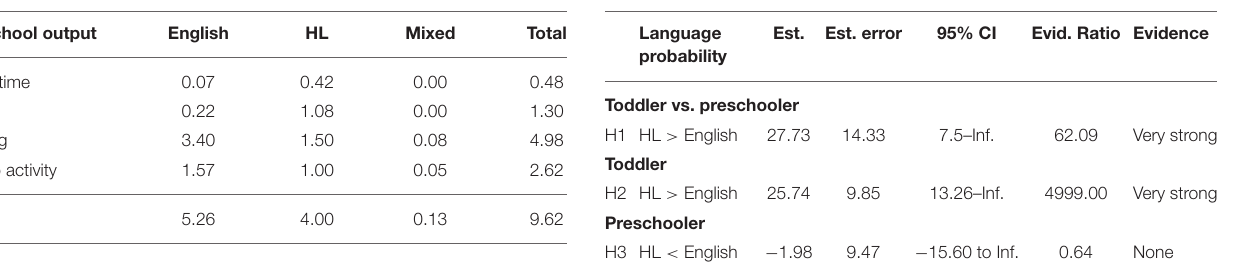
TABLE 4D | Output from preschool children in minutes. TABLE 5 | Results from the hypothesis tests for educator output per